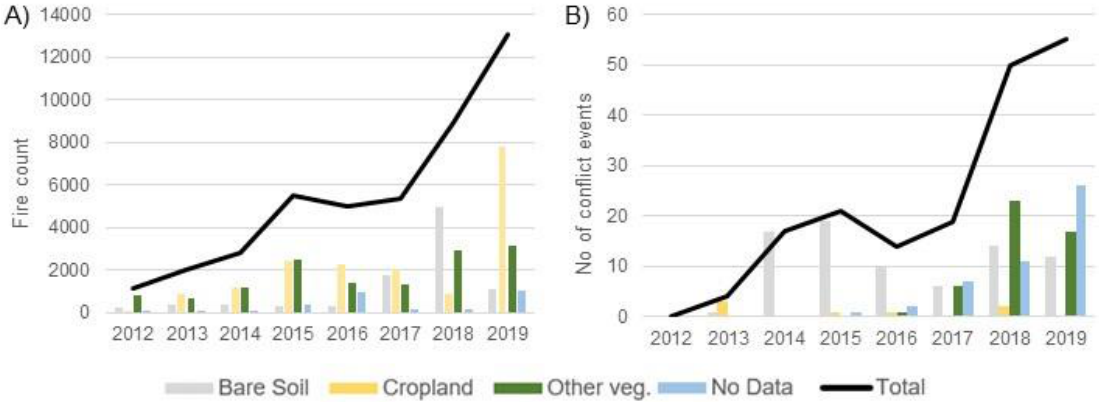
Figure 5. ( A ) Active fires recorded in the KR-I by the VIIRS instrument between 2012 and 2019, and ( B ) Conflict events recorded in the KR-I in the UCDP dataset between 2012 and 2019, and their corresponding LULC classes for the year in question. No Data refers to pixels with no LULC class assigned that occur predominantly in regions with rugged topography.